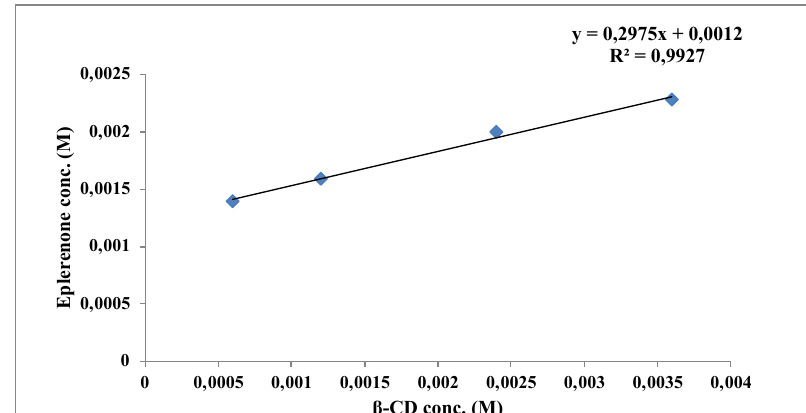
FIGURE 1 - Phase solubility diagram of Ep with β-CD. *β-CD: